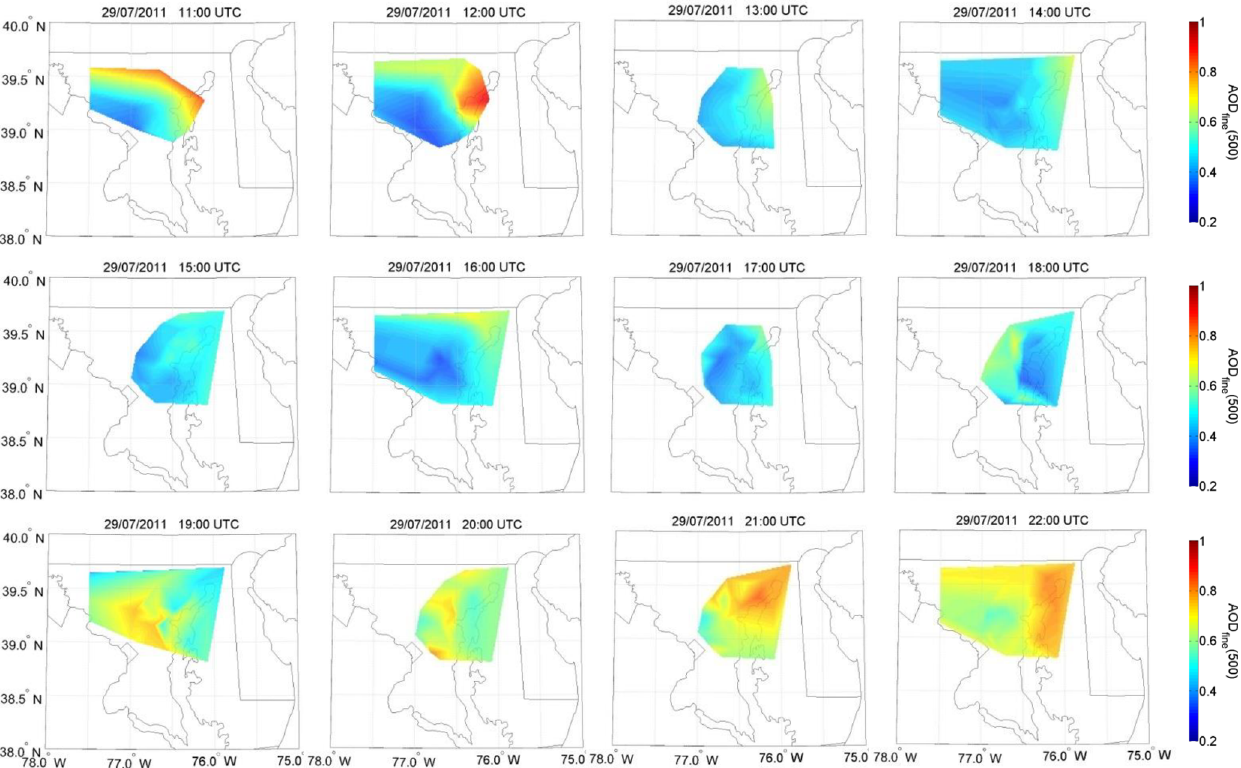
Figure 15. Temporal evolution of fine-mode aerosol optical depth (AOD fine ) at 500nm from AERONET-DRAGON over the Baltimore– Washington DC area on 29 July 2011.